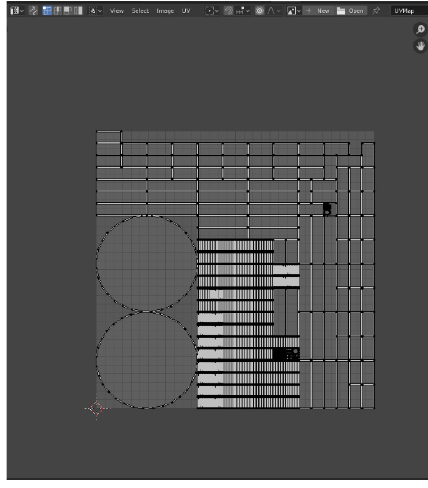
Figure 2. UV map example of a barrel.